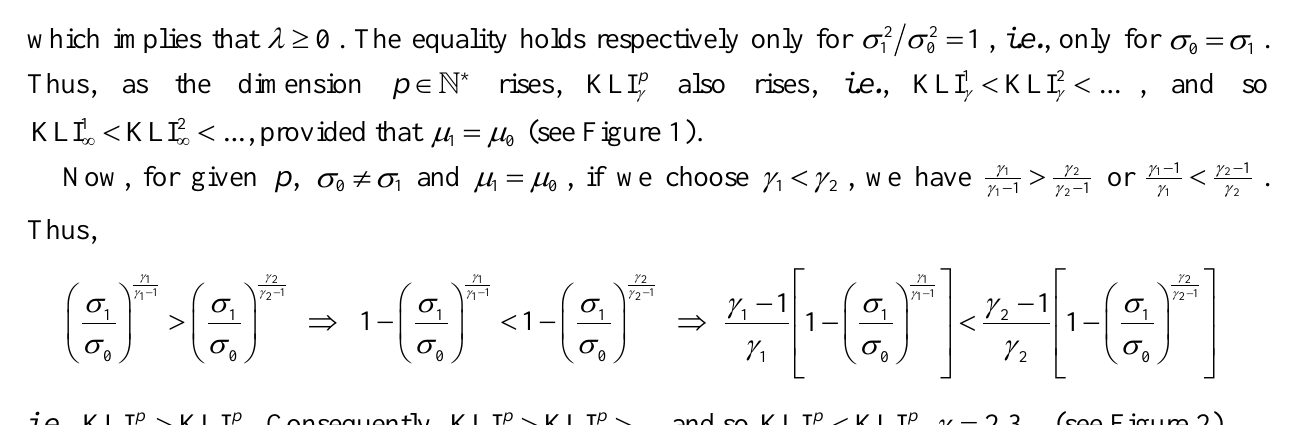
Figure 1. The graphs of the KLI p